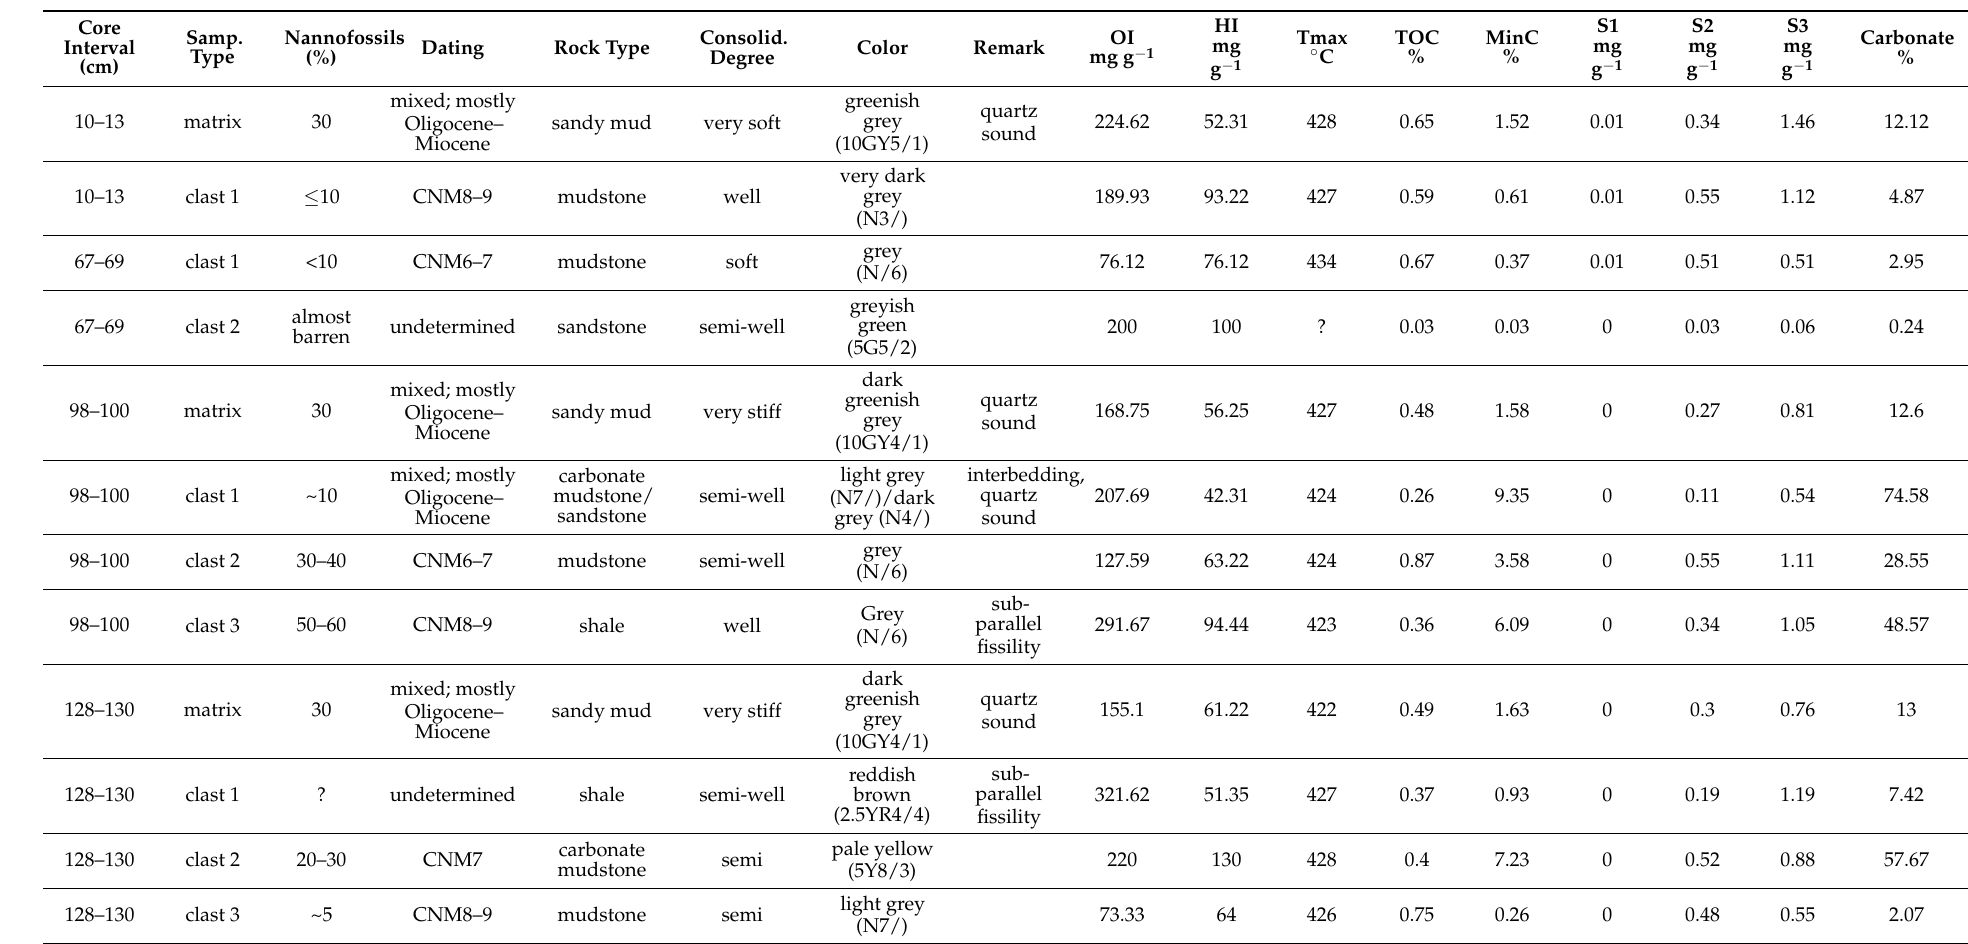
Table A5. Leipzig MV (LEV9GC